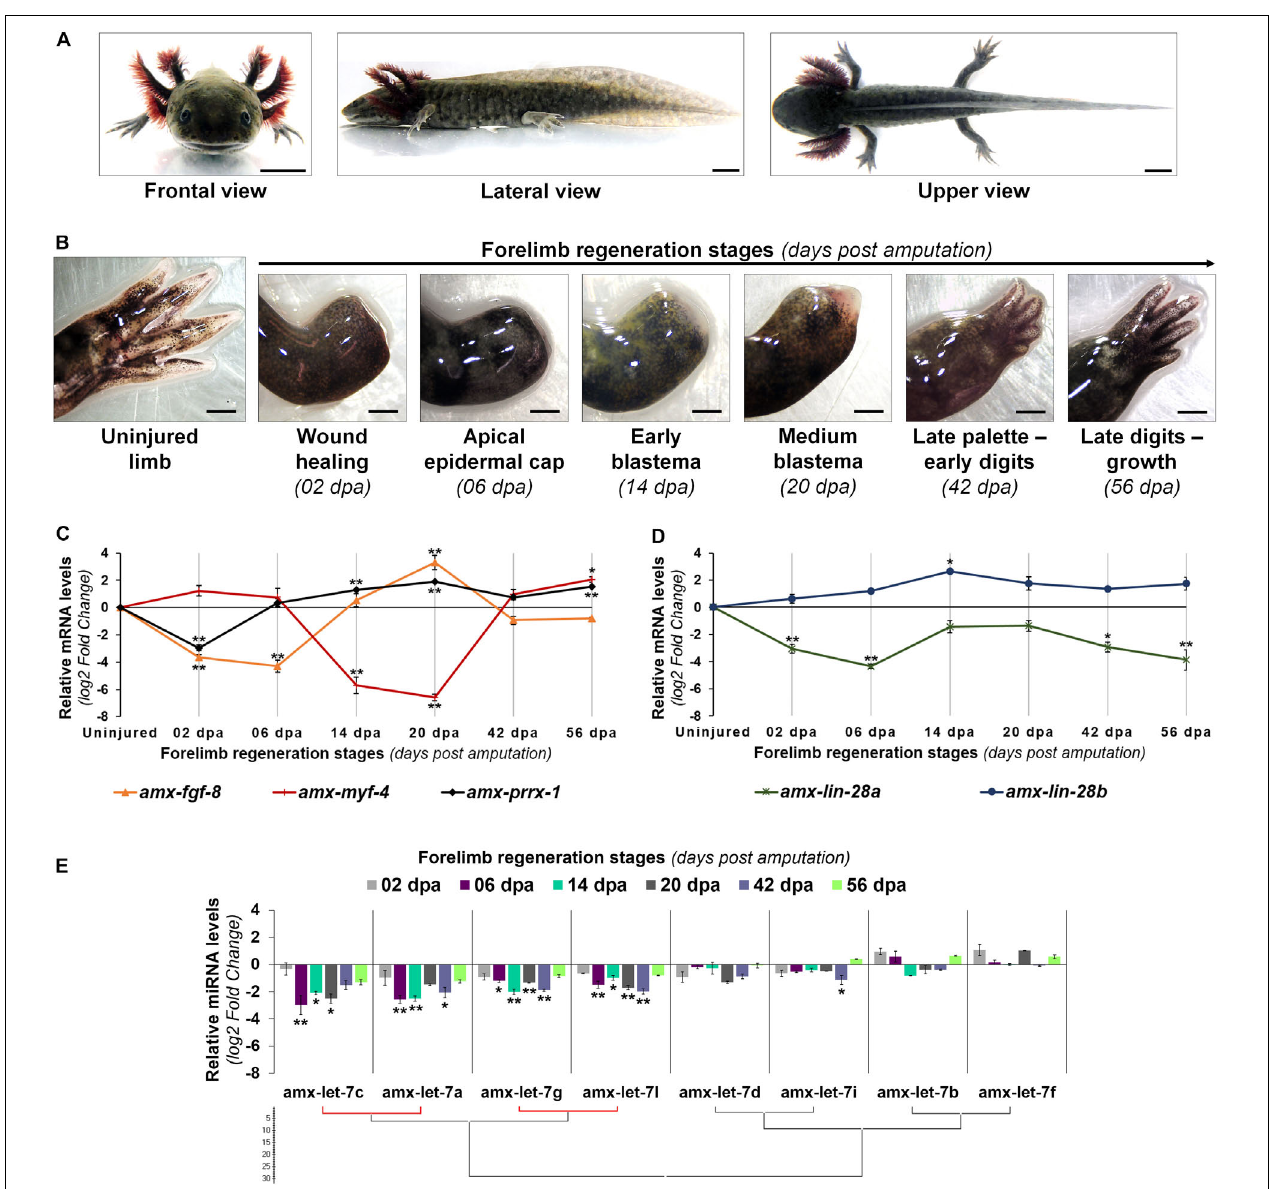
FIGURE 2 | Transcriptional profiles of Lin28 factors and mature let-7 microRNAs during forelimb regeneration. (A) Morphological features of a late juvenile axolotl (14-16 cm snout-tail length) from different views. Scale bars: 1 cm. (B) Temporal and morphological characterization of the forelimb regeneration stages analyzed in late juvenile axolotls. Scale bars: 1 mm. (C) Transcriptional expression profile of some genetic markers during limb epimorphosis. (D) Relative abundance of lin-28 transcripts during epimorphic regeneration. (E) Maturation patterns of the let-7 family across regeneration. Hierarchical clustering was made with the Ward algorithm and a Manhattan distance measure, indicating in red a positive Pearson correlation of P < 0.05. Data in the graphs are represented as mean ± s.e.m. ( n = 3); *, P < 0.05; **, P < 0.01; one-way ANOVA with post hoc Tukey–Kramer test vs uninjured